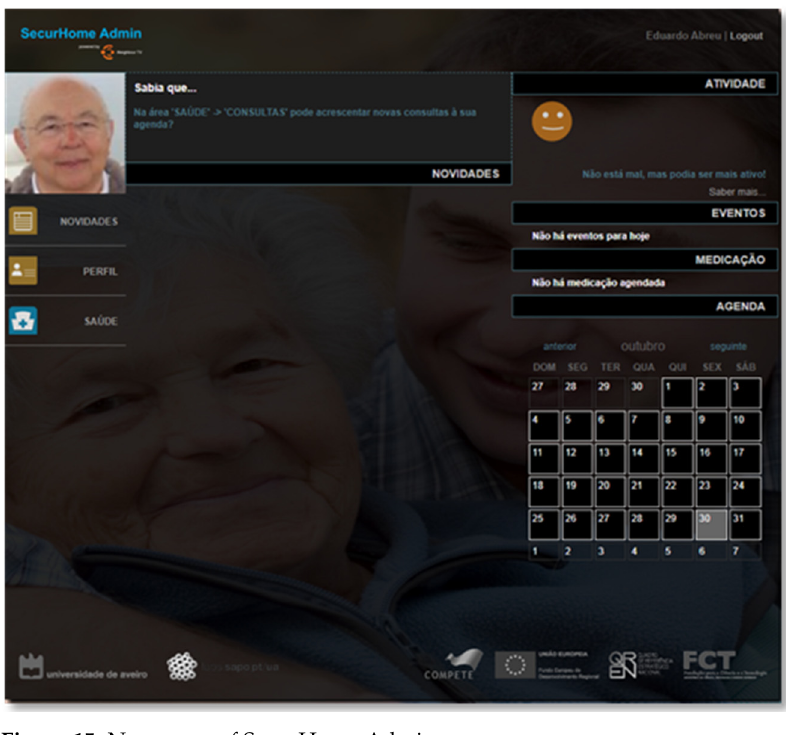
Figure 15. News area of SecurHome Admin.